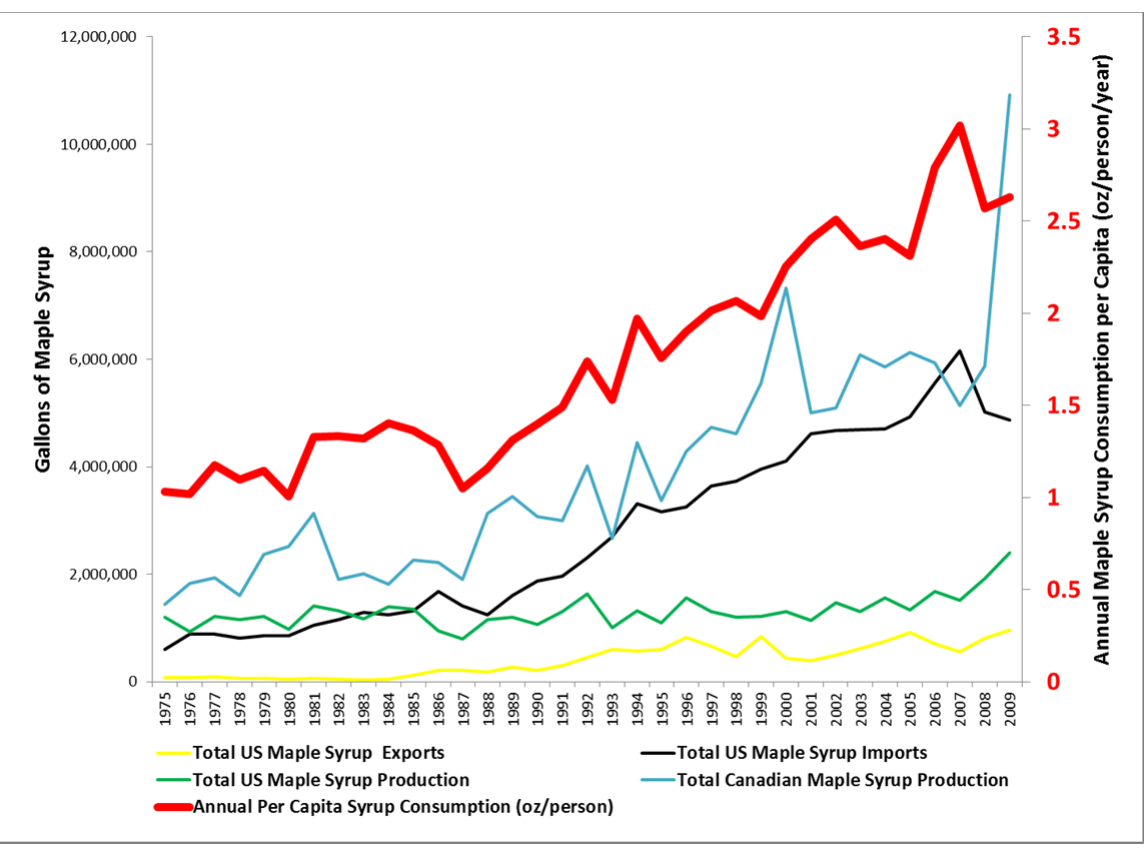
Figure 2. Maple Syrup Production, Imports and Exports in the United States and Canada, and Per Capita Annual Maple Syrup Consumption in the U.S.